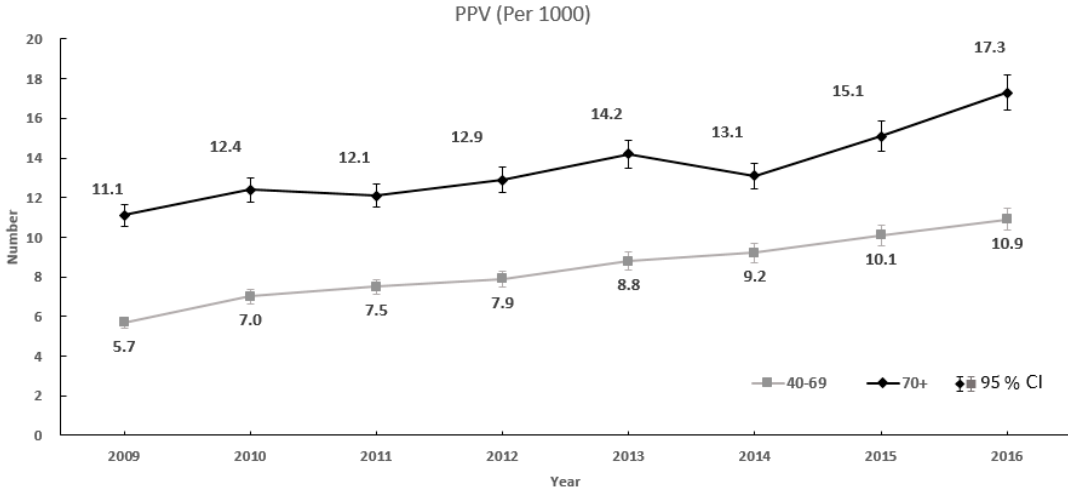
Figure 1. PPV of breast cancer screening by age group, 2009 to 2016.